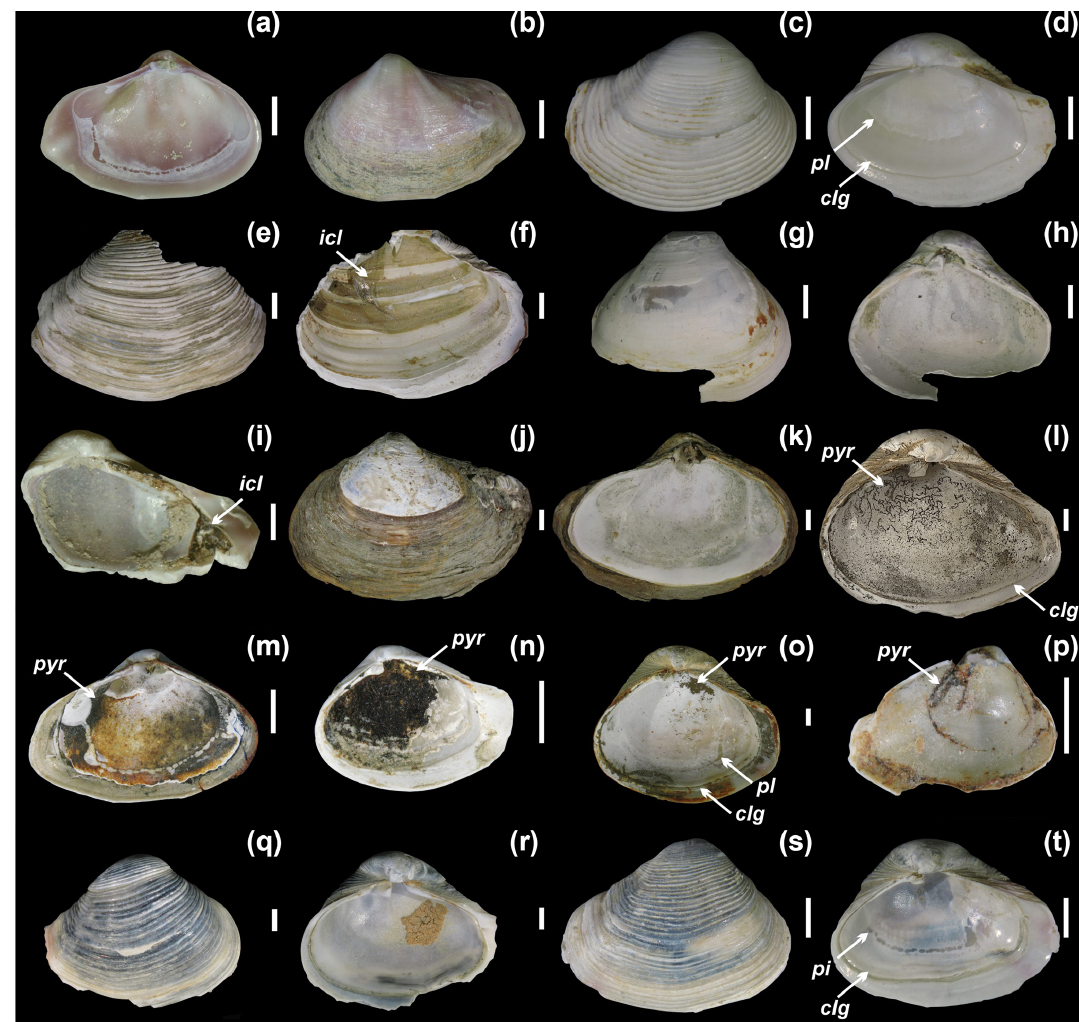
Figure 5. Varicorbula gibba from Po and Panzano (characterized by high sedimentation rates), showing the variability in external and internal preservation, with well-preserved valves with (a–b) or without periostracum (c–d) and with relicts of the main conchiolin layer (e–f) . The interiors of some specimens are lined by pyritic framboids that form isolated and dispersed framboids (k) , strings (l) , and patchy or continuous coatings on the conchiolin layer (m–p) . These specimens tend to be associated with brownish grains and streaks and with internal surface dissolution. Some specimens have a blueish color (q–t) . (a–b) Left valve, M28-65-70cm-29. (c–d) Right valve, M21-90-95cm-1. (e–f) Outer layer of the right valve, M13-65-70cm-25. (g–h) Inner layer of the right valve, M13-20-25cm-8. (i) Internal conchiolin layer exposed in a fragment, M20-120-125cm. (j–k) Left valve with periostracum and finely dispersed pyrite framboids on interior, M21-2-4cm-2. (l) Interior of the right valve with strings of pyrite framboids, M21-90-95cm. (m) Interior of the left valve lined by pyrite framboids, M28-110-115cm- 22. (n) Interior of the right valve almost continuously lined by pyrite framboids, M28-110-115cm-14. (o) Interior of the right valve lined by patches of pyrite framboids, M21-30-35cm-29. (p) Interior of the left valve with strings of oxidized pyrite framboids, M28-125-130cm-21. (q–r) Blue-stained right valve, M28-85-90cm-1. (s–t) Blue-stained right valve, M21-105-110cm-4. Note: clg – conchiolin groove, pl